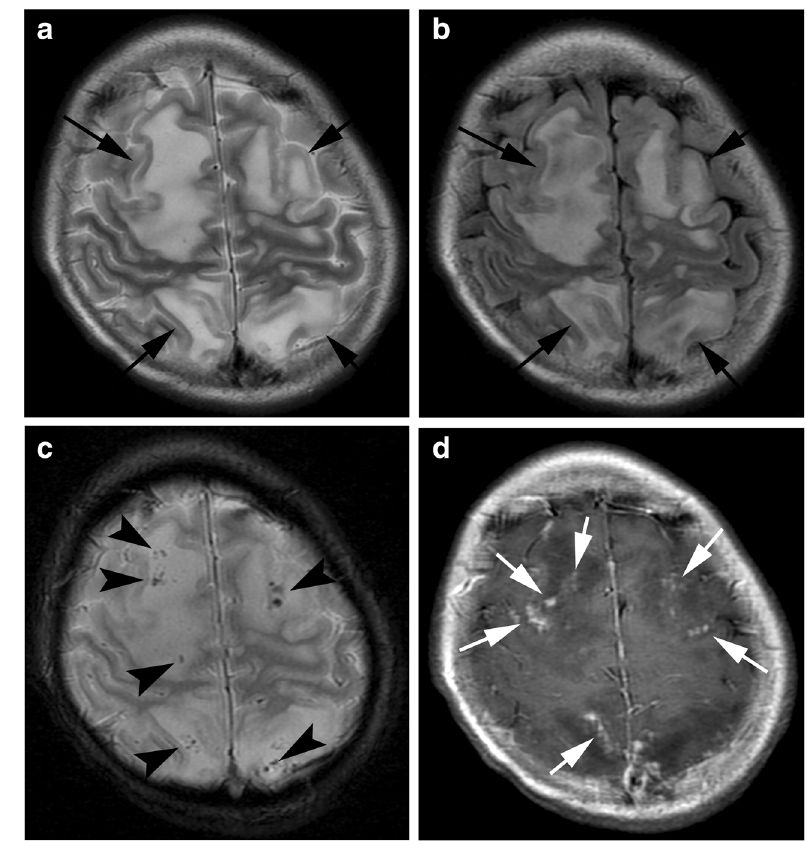
Fig. 3 Haemophagocytic lymphohistiocytosis. A 14-year- old girl with myelodysplastic syndrome presented with seizure. a AT2-weighted image shows patchy hyperintensities with swelling in the frontal and parietal lobes ( arrows ). b FLAIR image shows hyperintensity of these lesions ( arrows ). c T2*-weighted image shows a number of microhaemorrhages in these lesions ( arrowheads ). d Post- contrast image shows nodular enhancement along the leptmeninx ( white arrows )